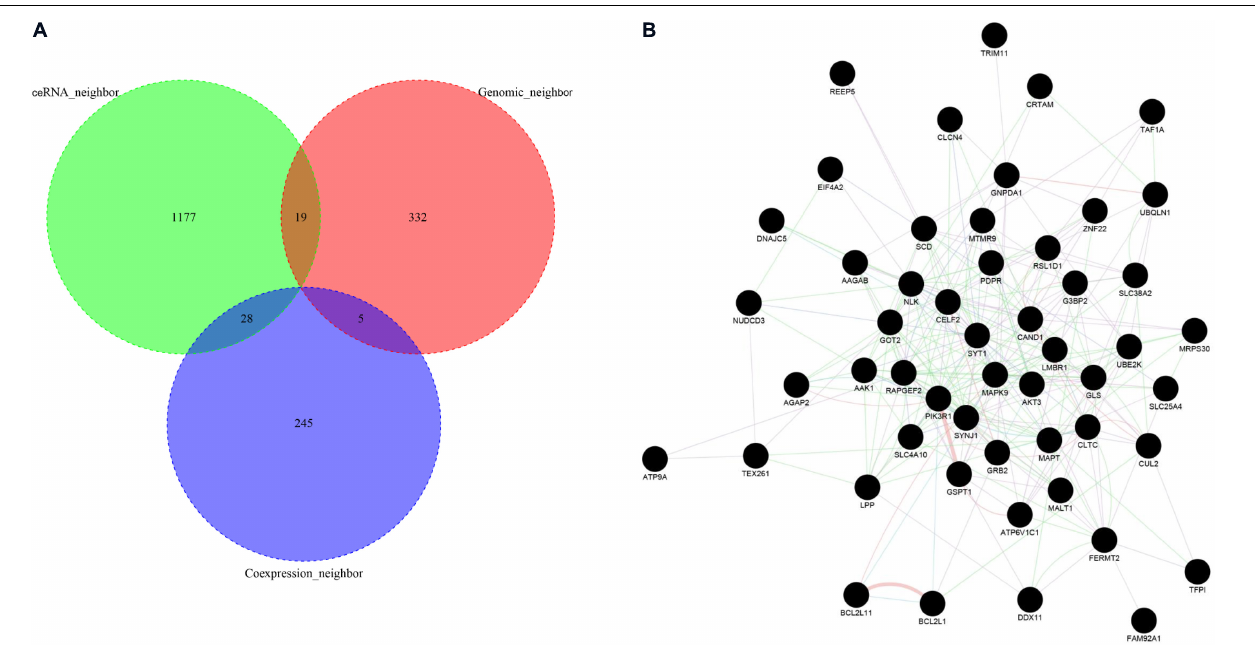
FIGURE 6 | Functional network analysis of high-reliable functional neighbor genes of ASD-related lncRNAs. (A) The Venn plot displays the intersection of three types of functional neighbor genes, i.e., genomic neighbors, competing endogenous RNA (ceRNA) neighbors, and gene co-expression neighbors. (B) The network graph depicts the functional interaction relationships between each high-reliable functional neighbor gene